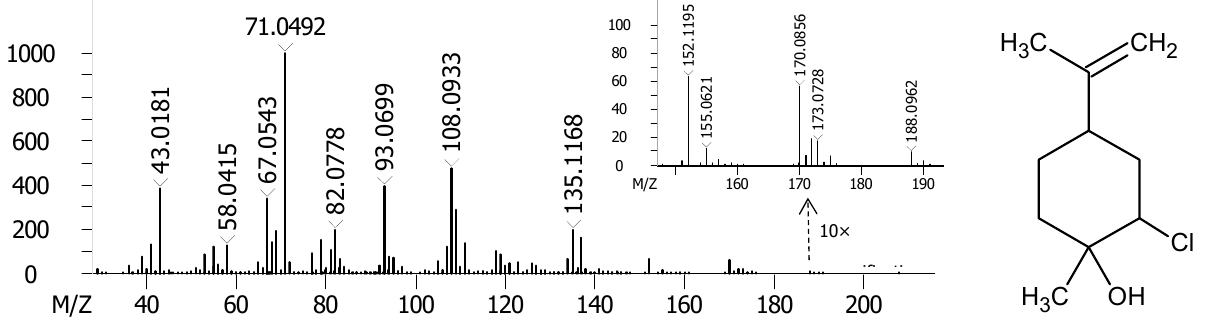
Figure 3. Mass spectrum and formula of 1-methyl-2-chloro-4 (1-methyletenyl)cyclohexanol with RT 818 s.